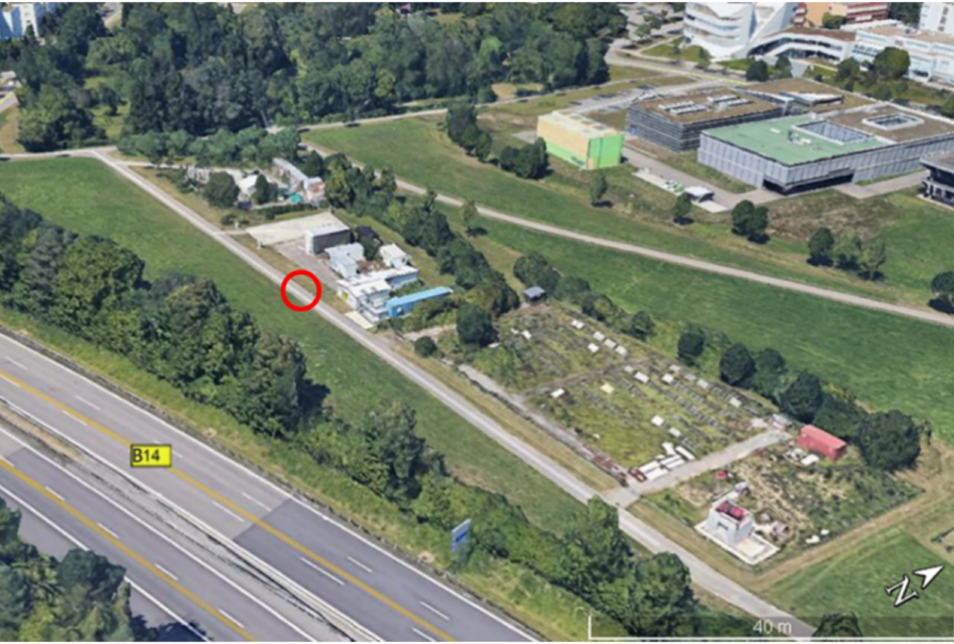
Figure 5. Google Earth image of the case study measurement site Am Lauchäcker, showing the federal highway B14 and the UAV take-off location (marked with the red